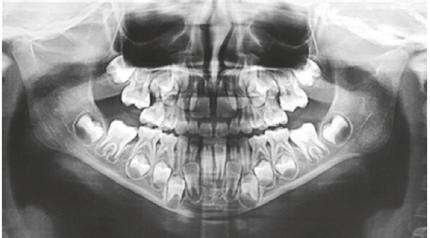
Figure 5: The complete anatomical restoring of the